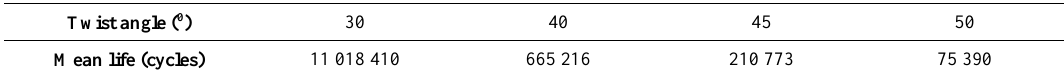
Table 10. Mean life at different stress